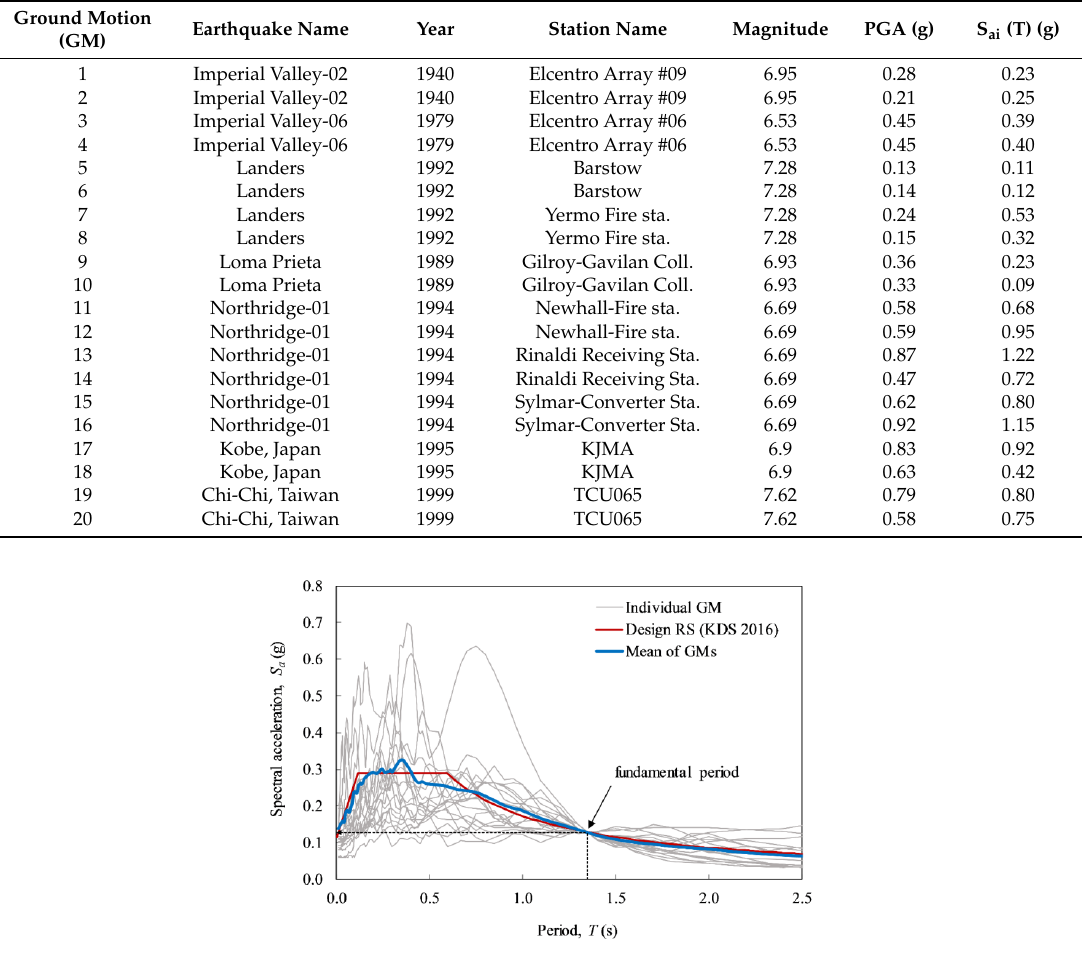
Figure 6. Scaled natural response spectra to Korean response spectrum at the fundamental period of structure (IM level S a = 0.13 g). Table 4. Unscaled time-history accelerations.